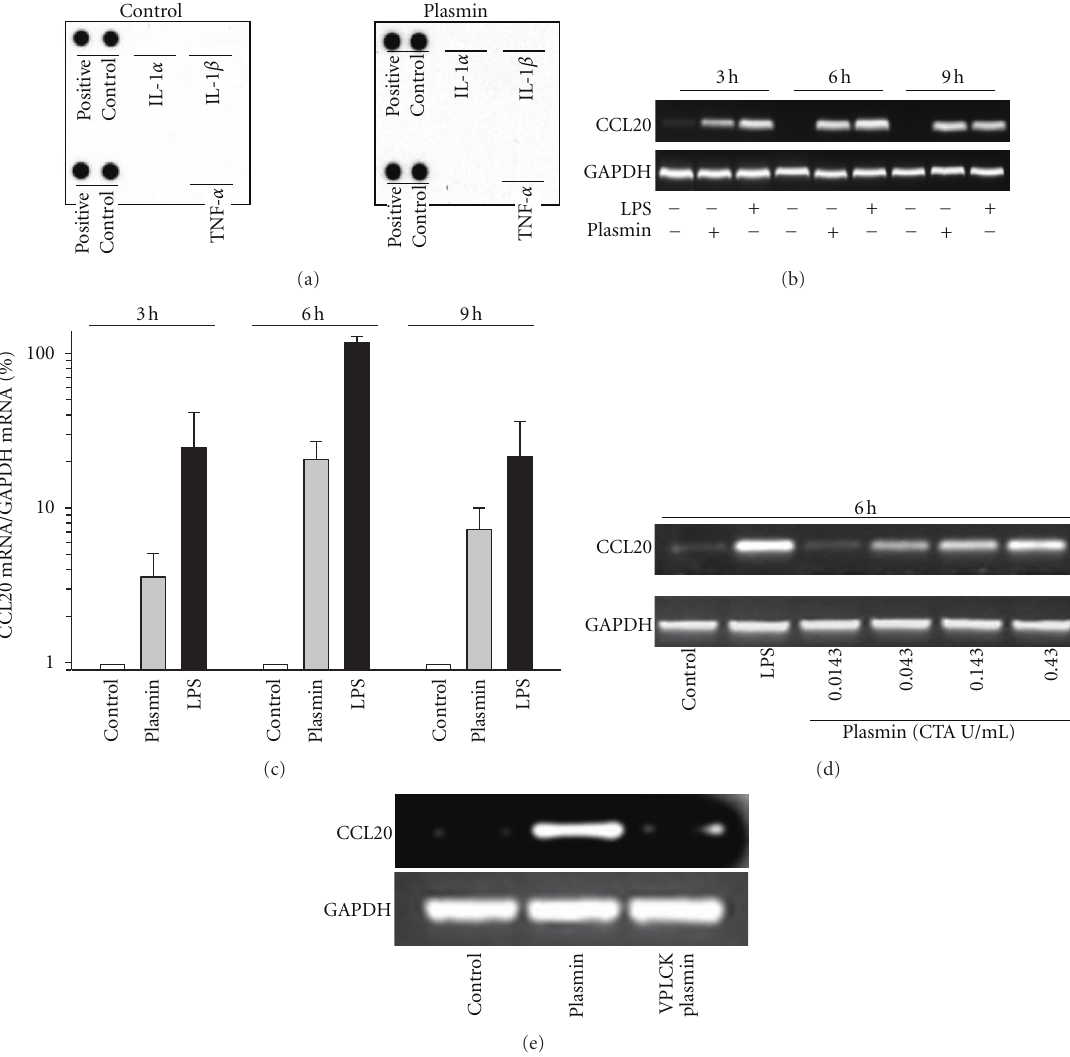
Figure 2: Plasmin induces time- and concentration-dependent expression of CCL20 mRNA in dendritic cells. (a) Plasmin does not induce release of the proinflammatory cytokines TNF- α , IL-1 α , and IL-1 β . At day 6, dendritic cells were left untreated or stimulated with plasmin (0.143CTAU/mL) for 24h. Release of cytokines in the culture media was analyzed with the proteome profiler array. (b) Plasmin induces time-dependent expression of CCL20 mRNA in dendritic cells. Dendritic cells were treated with plasmin (0.143 CTAU/mL) or the positive control LPS (0.5 μ g/mL) for the indicated time. mRNA was isolated and subjected to RT-PCR (b) and real time qPCR (c) analysis using CCL20-specific primers; GAPDH served as control. Results are mean ± SEM of 3 experiments. (d) Dendritic cells were treated for 6 h with the indicated concentrations of plasmin, and CCL20 mRNA expression was analyzed by RT-PCR. (e) Proteolytic activity of plasmin is required for the induction of CCL20 mRNA expression. Dendritic cells were stimulated either with plasmin (0.143 CTAU/mL) or the equivalent amount of catalytically inactivated plasmin (VPLCK plasmin) for 6h. CCL20 mRNA expression was analyzed by RT-PCR. All data are representative of at least 3 independent